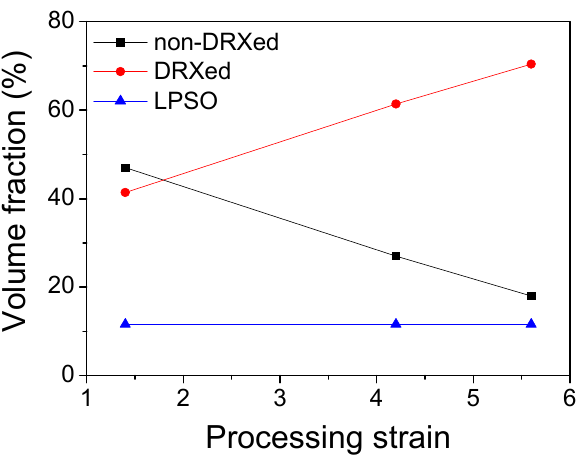
Figure 3. Evolution of the volume fraction of LPSO phase, DRXed grains, and non-DRXed grains as a function of the processing strain.